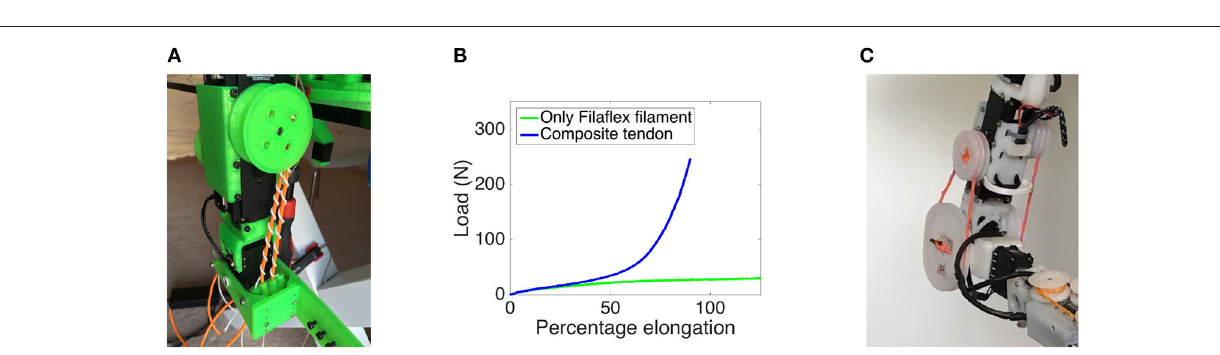
FIGURE 3 | The composite rubber/nylon tendons on the elbow joint of the GummiArm v1.0 are shown in (A) , highlighting the biceps servo and tendons. Note the uni-directional agonist-antagonist setup, with the tendon set attached to one side of one actuated pulley. The tendons are composed of a soft 2.85mm Filaflex filament (Recreus, La Torreta, Spain) and a stiff 1.5 mm nylon thread twinned around it. A pitch of 0.1 revolutions per mm was used for the tensile test performed here. The results are shown in (B) , where the non-linear spring response of the tendons can be clearly seen. The testing was performed on an Instron (Wycombe, United Kingdom) 5582 frame with a static 100kN load cell (Instron UK195). Load (y-axis) vs elongation (x-axis) of tendons shown, comparing the Filaflex filament by itself with the composite tendon design. In (C) the elbow joint for the GummiArmCE/RE is shown for comparison, showing the bi-directional agonist-antagonist setup,